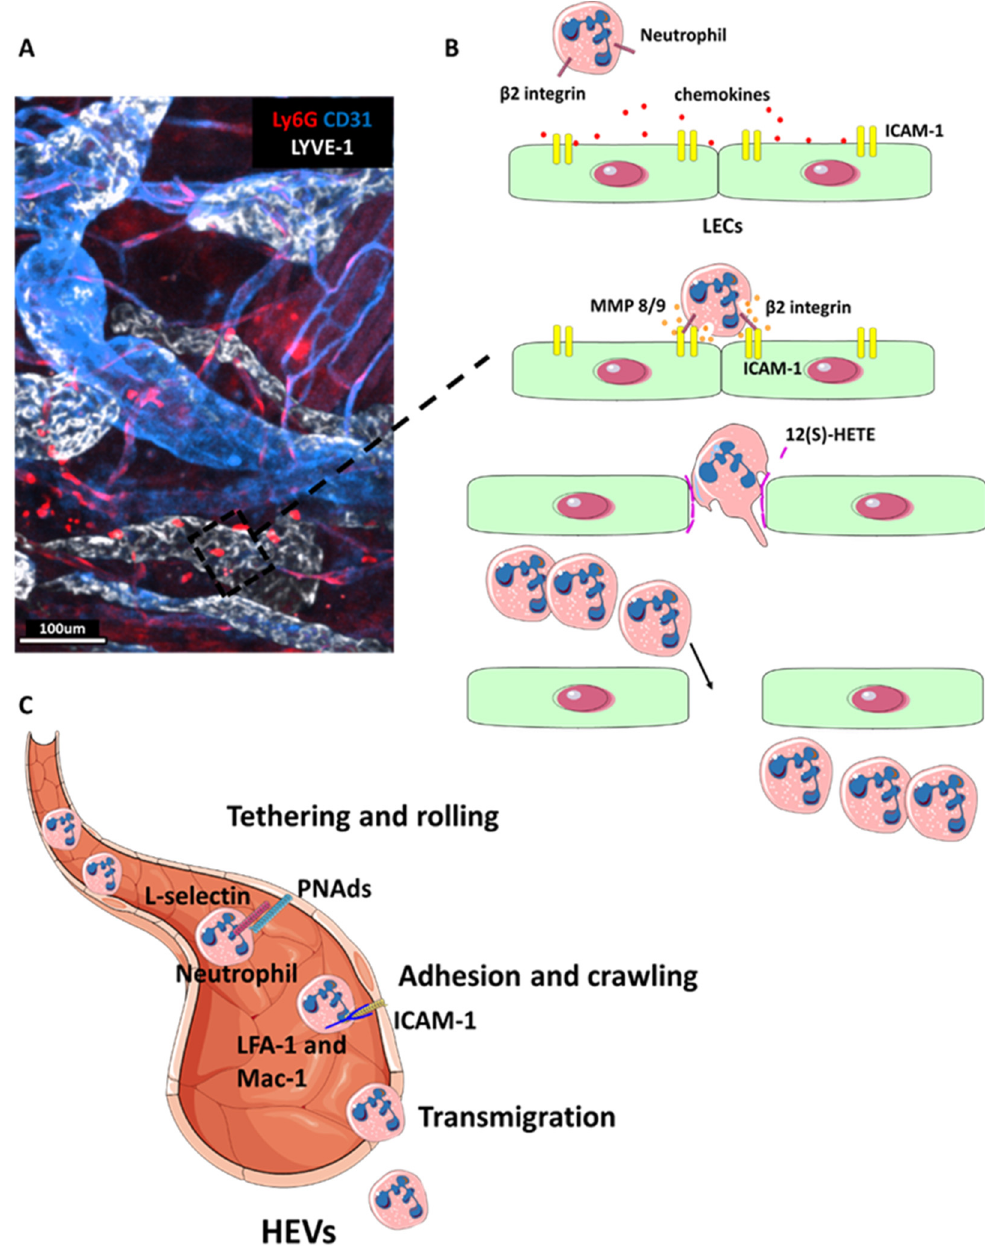
Figure 3. Neutrophil migration to lymphoid organs. ( A ) Two-photon microscopy image of a section of inflamed skin in a Ly6G-Tomato reporter mouse [48] stained with LYVE-1 (white) to visualise LECs and endothelial cells with CD31 (blue). Neutrophils (red) can be seen in and around lymphatic vessels. ( B ) Schematic representation of neutrophil transmigration across lymphatic endothelium. First, neutrophils chemotax toward LECs following inflammation-induced release of chemokines such as CXCL8 in humans and CXCL1 in mice [49]. Next, neutrophils adhere to inflamed LECs via integrin binding to ICAM-1. This triggers the secretion of MMP8, MMP9 and exocytosis of chemorepellent 12(S)-HETE, which together promote transient junctional retraction and neutrophil transmigration. The resulting gap in the lymphatic endothelium serves as a hotspot for rapid neutrophil transmigration. Adapted from D.G. Jackson, Frontier Immunology , 2019 [2]. ( C ) Diagram showing neutrophil entry into the lymph node via HEVs. Neutrophil express L-selectin which binds to glycoproteins expressed on the HEVs walls, such as peripheral node addressins (PNAds) to allow tethering and rolling, which promote rapid adhesion and emigration [15]. Neutrophil adhesion is mediated via binding of ICAM-1 to integrins LFA-1 and Mac-1. In particular, LFA-1 mediates neutrophil adhesion and Mac-1 facilitates subsequent crawling [50]. Neutrophil lymphatic migration is guided by chemotactic stimuli. Chemokine recep- tor CCR7 regulates entry of DCs, monocytes and T cells into lymph nodes [51–53]. CCR7